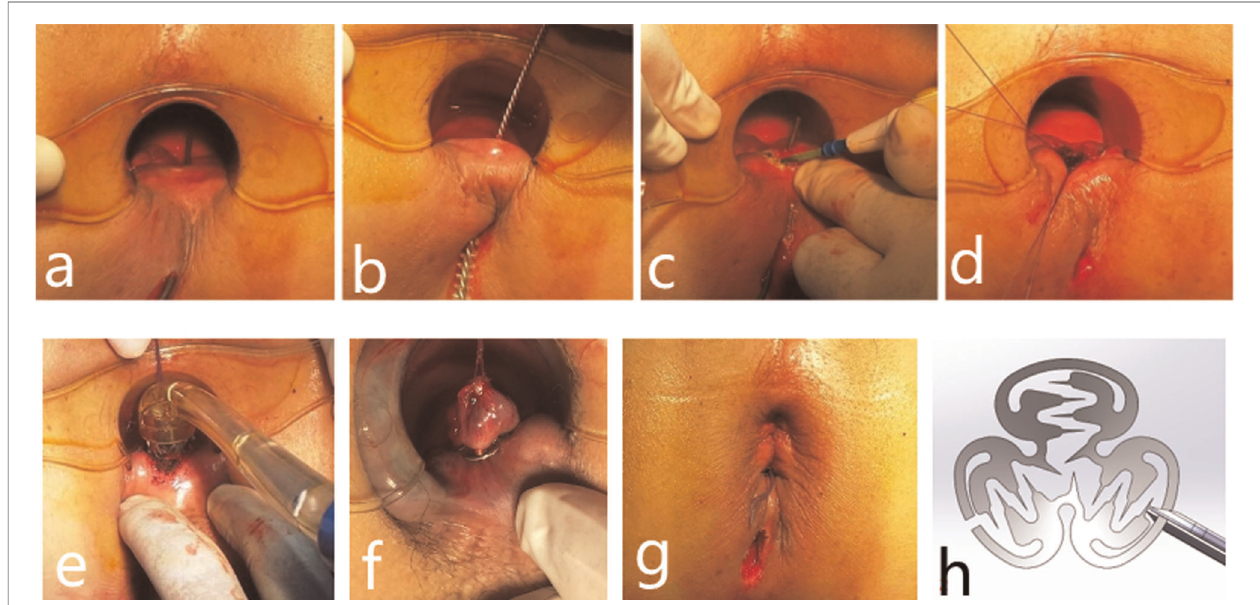
FIGURE 1 | A 36-year-old man with fi stula treated by the IOAC procedure with complete healing demonstrated on follow-up anorectal color ultrasound. ( A – G ) Procedure for a patient undergoing IOAC surgery and ( H ) alloy anal fi stula